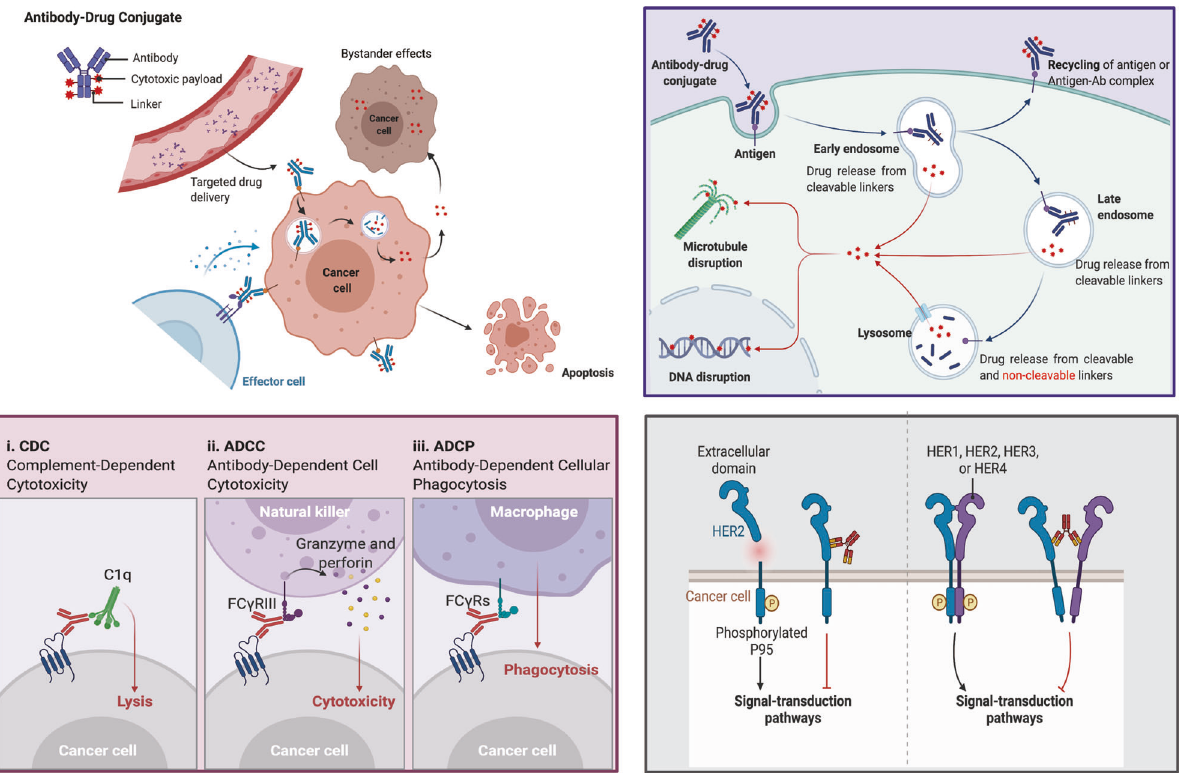
Fig. 4 The overview of the mechanisms of ADC for killing cancer cells via different approaches. Upper-Right: The main core mechanism of action of ADCs; Lower-Left: The antibody component of ADCs engages with immune effector cells to elicit antitumor immunity including CDC, ADCC, and ADCP effects; Lower-Right: The antibody component of ADCs retains its activity pro fi le and can therefore interfere with target function, dampen downstream signaling to inhibit tumor growth. Created with